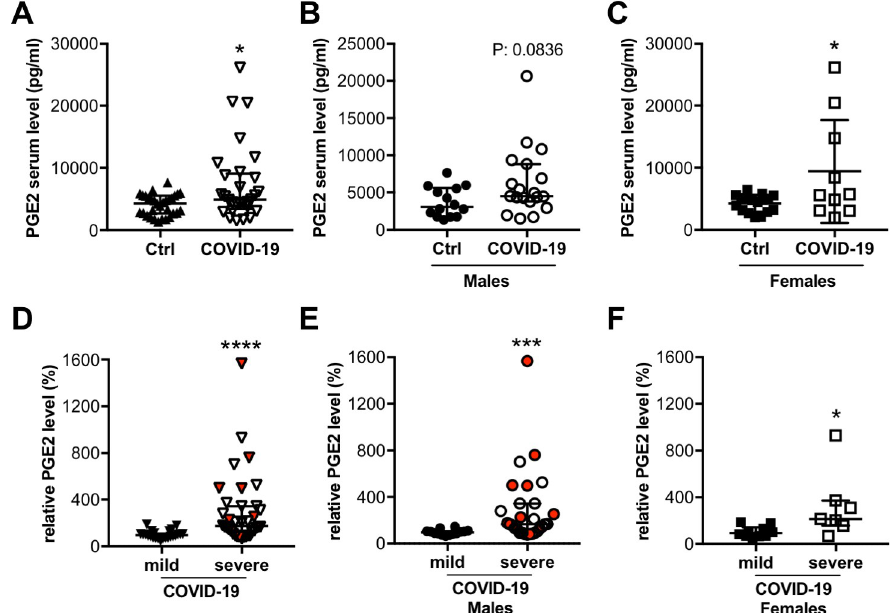
Fig 2. Circulating PGE2 levels are elevated in COVID-19 patients. The dot plots summarize circulating serum PGE2 levels (pg/ml) of (A) COVID-19 patients (n = 29) and healthy controls (n = 31), and separately (B) for males (COVID- 19 male patients n = 19; healthy male controls n = 14) and (C) for females (COVID-19 female patients n = 10; healthy female controls n = 17). The dot plots summarize relative circulating plasma PGE2 levels (in %) (D) of patients with severe (n = 36) and mild (n = 24) disease, and separately (E) for males (severe affected males n = 29; mild affected males n = 14) and (F) for females (severe affected females n = 7; mild affected females n = 10); the median of patients with mild disease was set at 100%. Dots representing patients who died with COVID-19 disease are highlighted in red. (A, B, D-F) Data are presented as median ± IQR, � P < 0.05, ��� P < 0.001, ���� P < 0.0001, Mann-Whitney-U test. (C) Data are presented as mean ± SD, � P < 0.05, unpaired two-tailed t -test. Underlying data can be found in S1